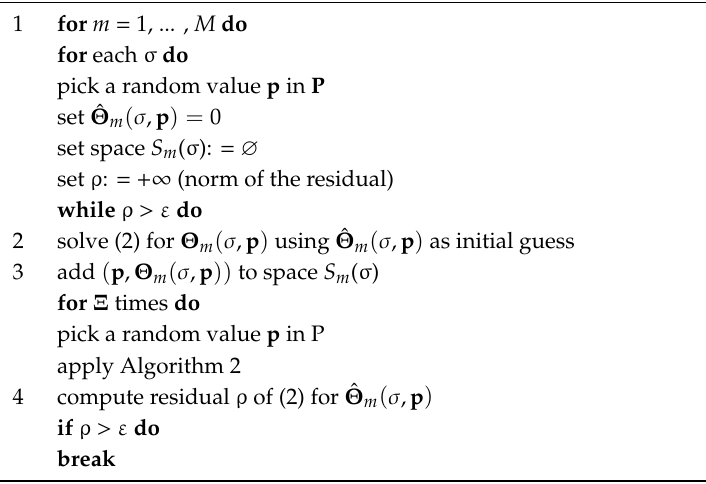
Algorithm 1: Extraction of Projection